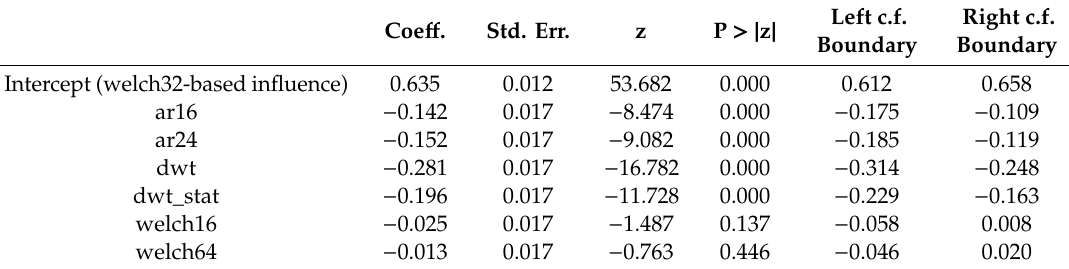
Table 3. Results of the mixed linear model analysis for data from Table 2. The values presented are coe ffi cients of a linear model calculated by the analysis procedure, standard error, statistic, and p -value of a test for statistical significance and left and right boundaries of the confidence interval for the influence of each algorithm in comparison to reference algorithm (welch32). Boundary probabilities of the confidence interval are 0.025 and